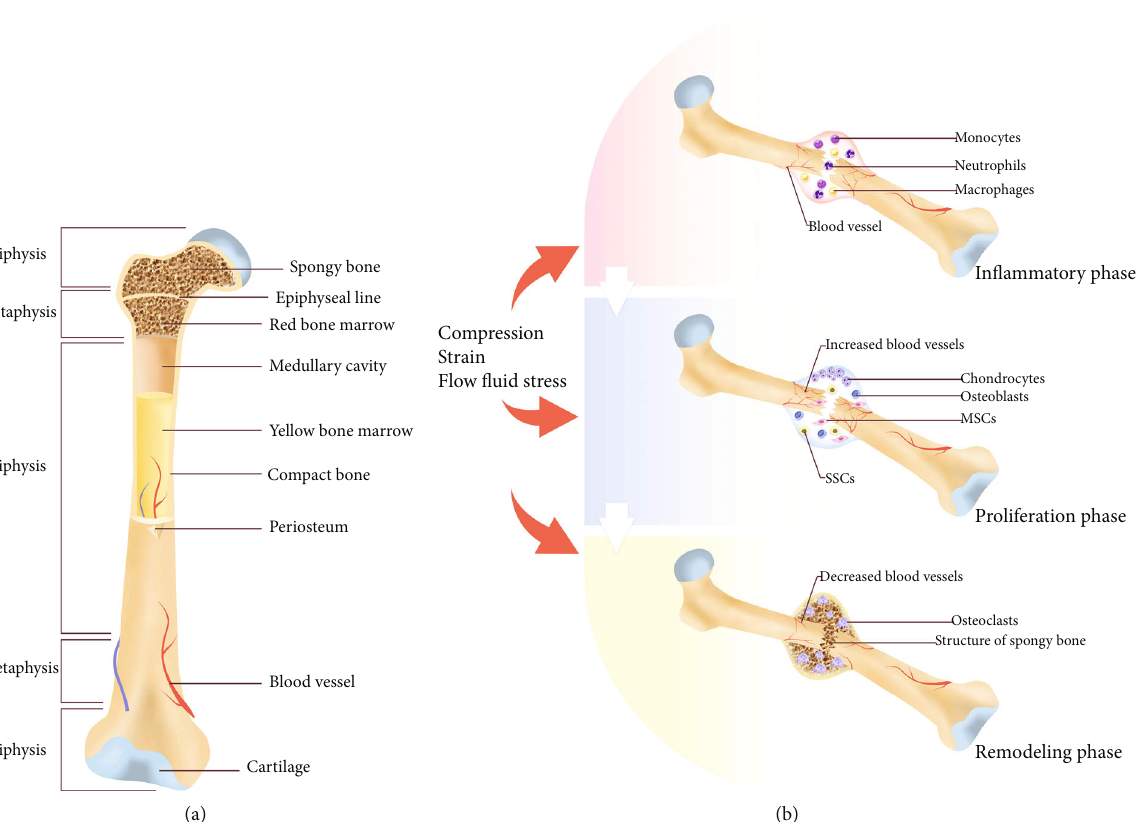
Figure 1: Bone structure and bone repair processes. (a) The basic anatomic structure of long bone. (b) The three phases in bone injury